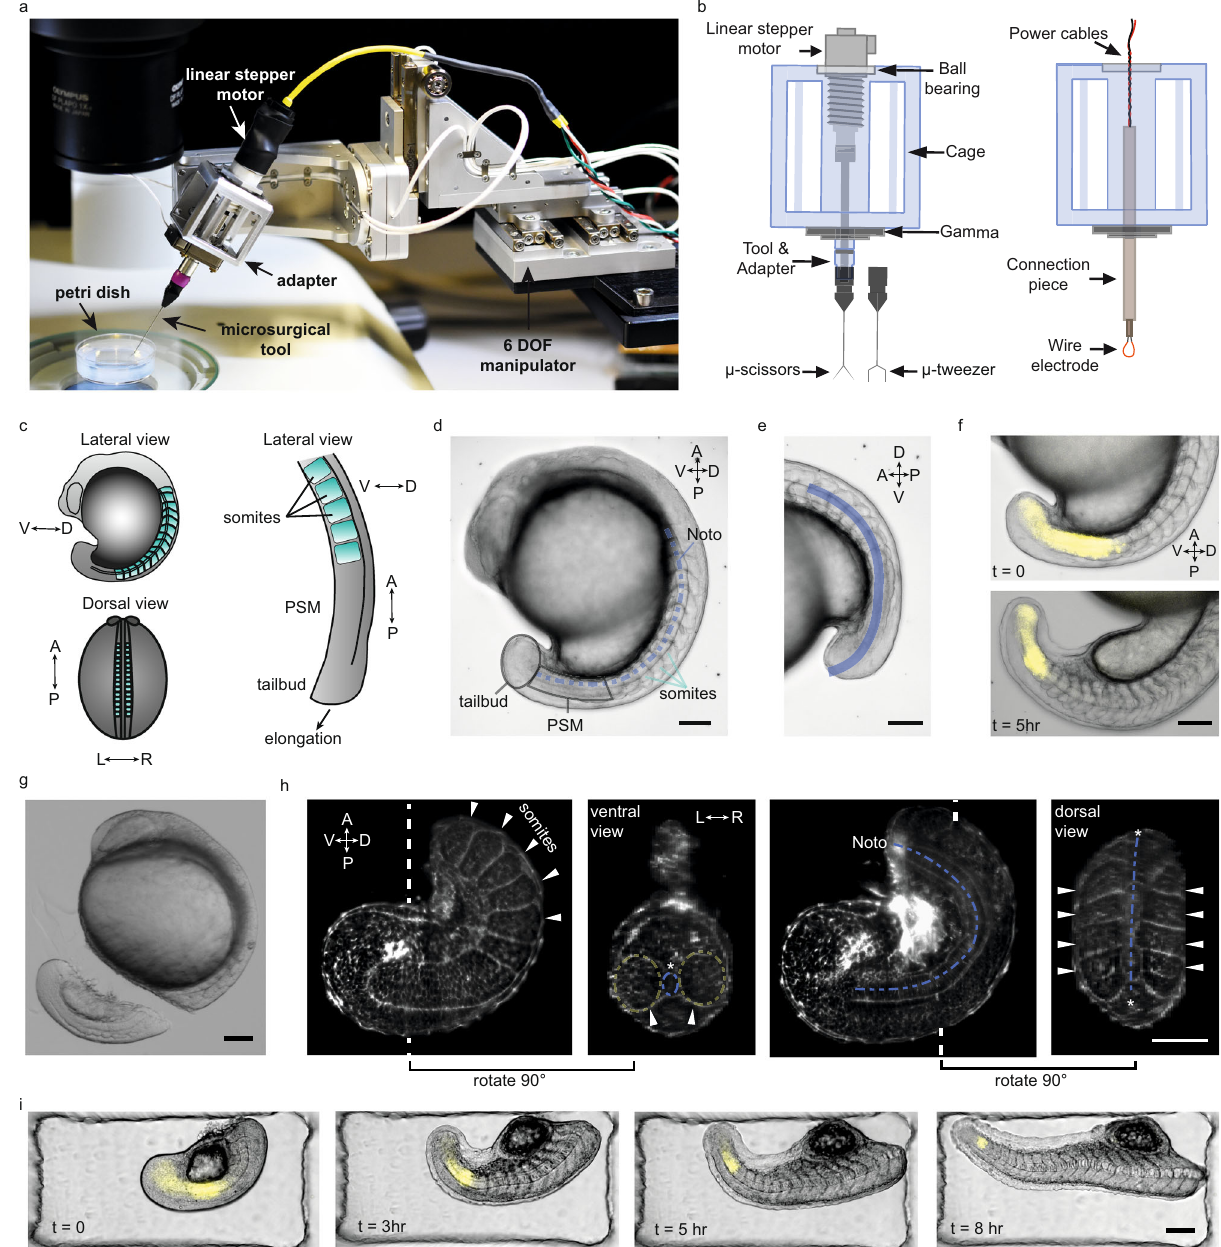
Fig. 1 | Robotic platform enables precise microsurgery of the zebra fi sh tail. a Robotictissuemicromanipulationplatformalongwiththestereomicroscopeand operation chamber. b Schematic illustration of the adapters designed to hold actuated and non-actuated instruments (not to scale). c Schematic showing the zebra fi shembryofromdifferentanatomicalaxes(V/D:ventral/dorsal,A/P:anterior/ posterior, L/R: left/right). d A representative bright fi eld (BF) image of a zebra fi sh embryo.Tissuesthatarestudiedinthisworkareindicatedontheembryo. e Lineof interest indicated with blue is generated to measure the AP tail length from BF